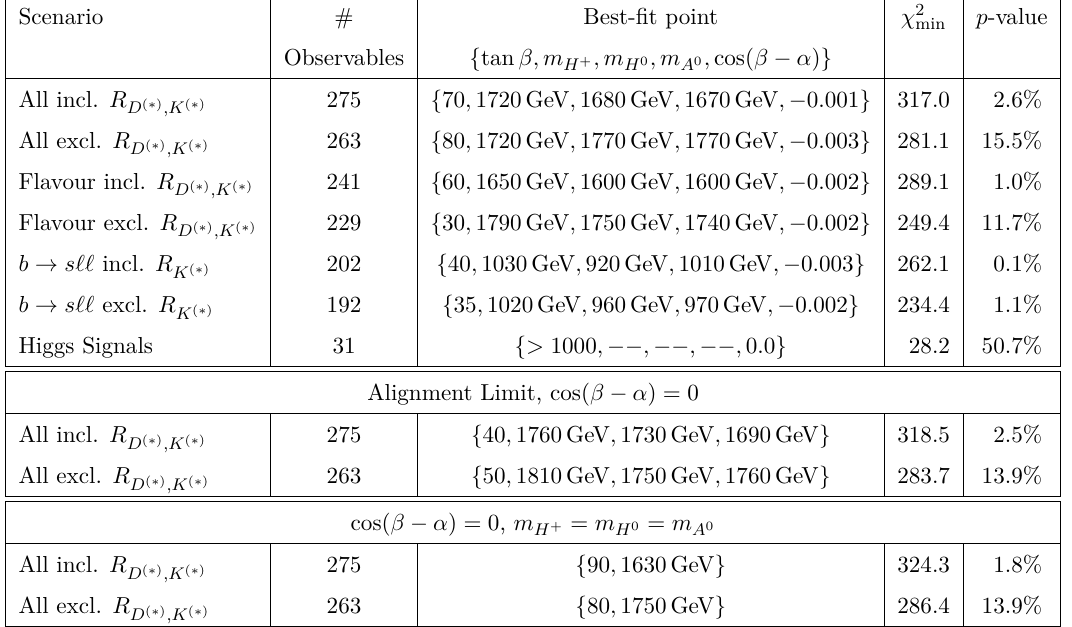
Table 3 . Best fit points of 2HDM-I parameter fits for various groups of observables using the constraints from theory to inform the physical parameter